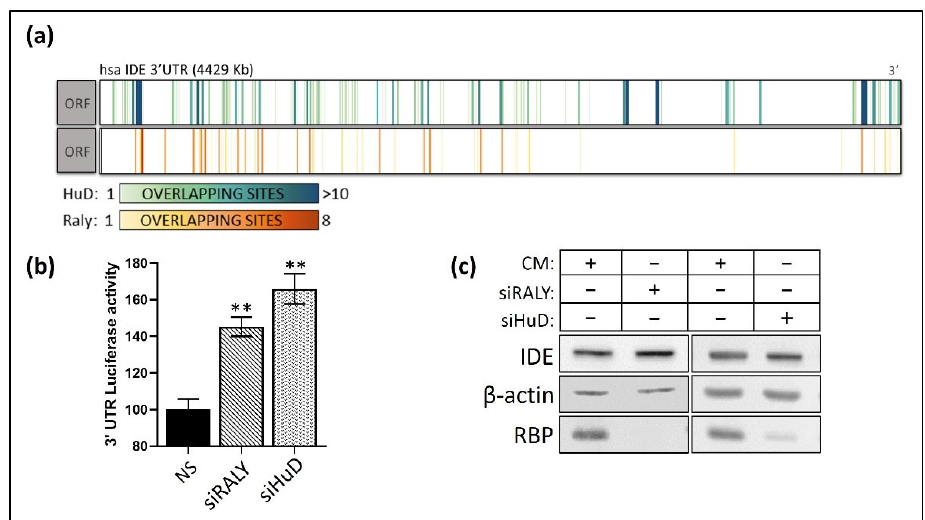
Figure 7. RALY and HuD are post ‐ transcriptional regulators of IDE. ( a ) Representation of predicted target RALY and HuD sites for human IDE 3 ′ UTR. ( b ) Luciferase reporter activity in HEK ‐ 293 cells transfected with the NS or siRNA against HuD or RALY and the IDE 3 ′ UTRs. Data are expressed as relative luciferase activities compared to the activity in control samples co ‐ transfected with an equal concentration of NS. ** p < 0.01 (significantly different from cells co ‐ transfected with NS and the siRBPs). ( c ) Western blot analysis of IDE in SH cells transfected with the respective RBP silencing.